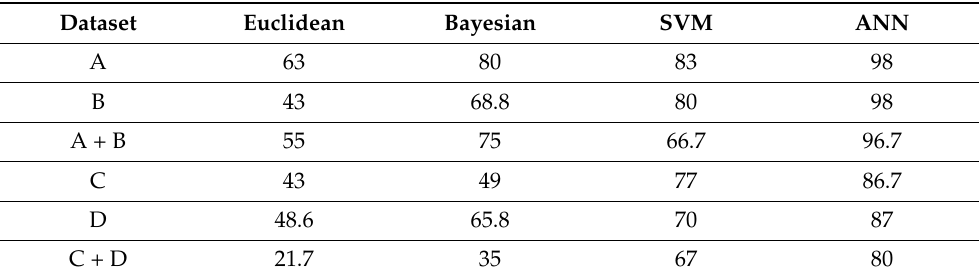
Table 6. Performance of feature vector PDHFs on different